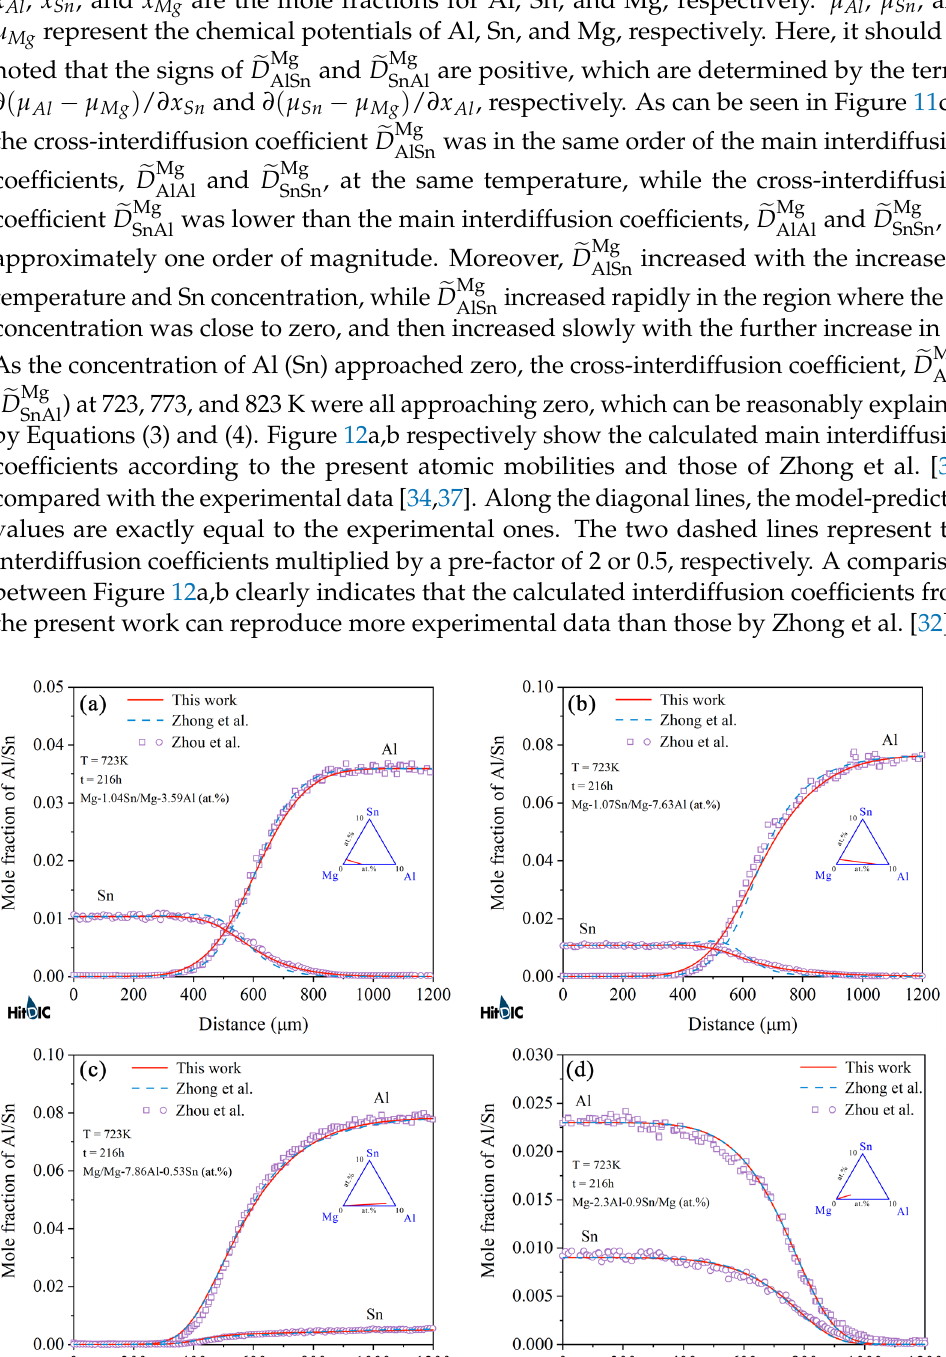
Figure 8. ( a – d ) Model-predicted composition–distance profiles of the different hcp Mg–Al–Sn diffusion couples annealed at 773 K for 6 h from the present atomic mobilities (solid lines) compared with those of Zhong et al. [32] (dashed lines) and the experimental data [34] (in symbols).